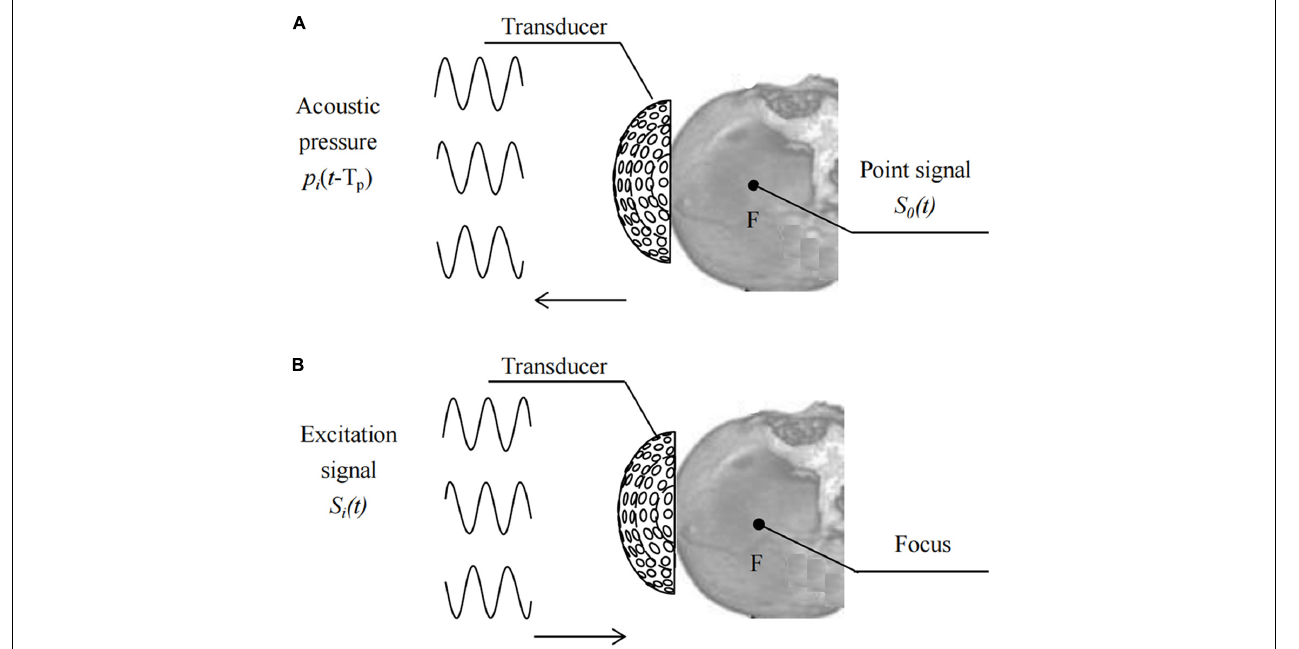
FIGURE 2 | Schematic of (A) acquiring signals and (B) focusing at F using